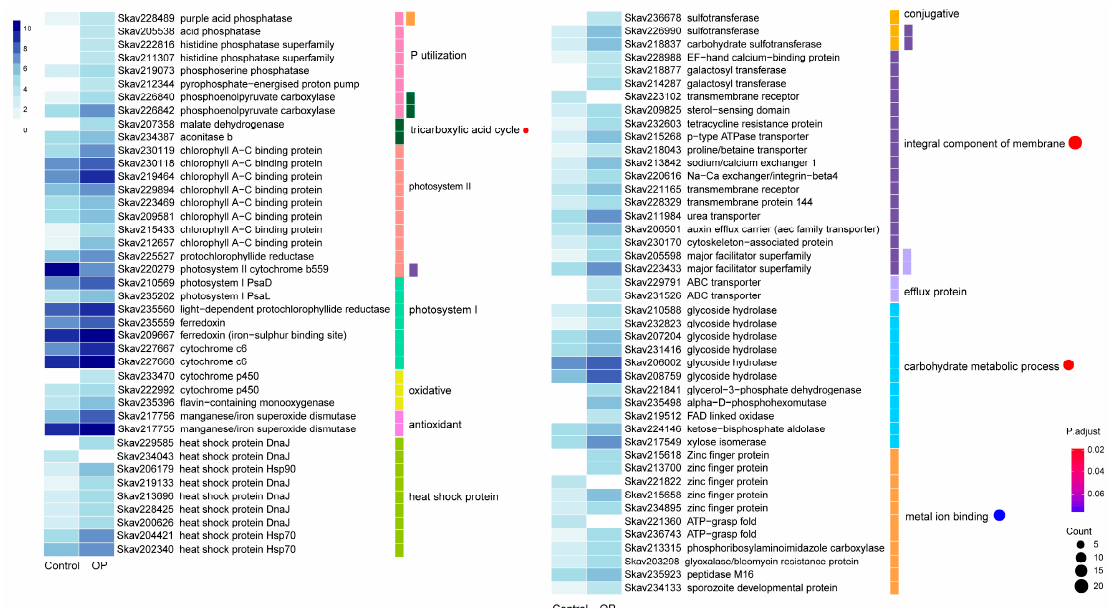
Figure 4. Di ff erential gene expression in response to organophosphate. The heatmap color strength represents log2-transformed gene expression by fragments per kilo-base of exon model per million mapped fragments (FPKM), from dark blue (highest), light blue, to white (lowest). Each color bar on the middle right marks a functional category. Each dot marks a category based on GO enrichment ( p -value cuto ff = 0.1). The dot size represents the enriched DEGs count. The color strength represents the p -value. Control: SymkaSL2 was grown in L1 at 25 ◦ C. OP: SymkaSL4 was grown in L1 medium with DIP replaced by glycerophosphate at 25 ◦ C.